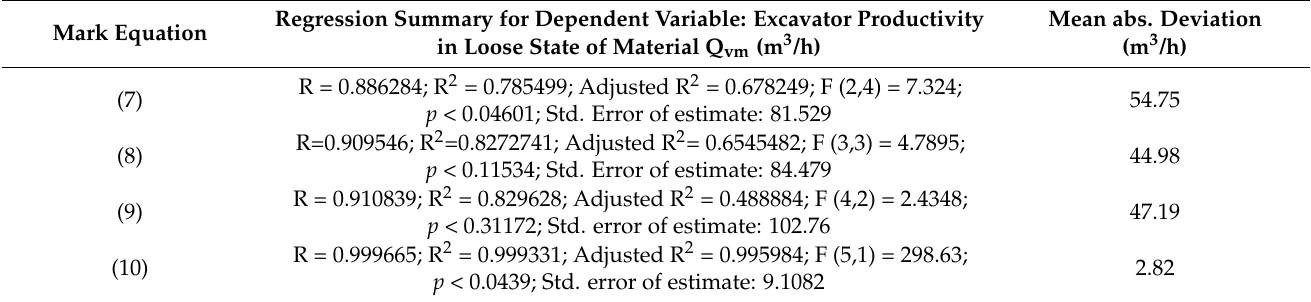
Mean abs. Deviation (m 3